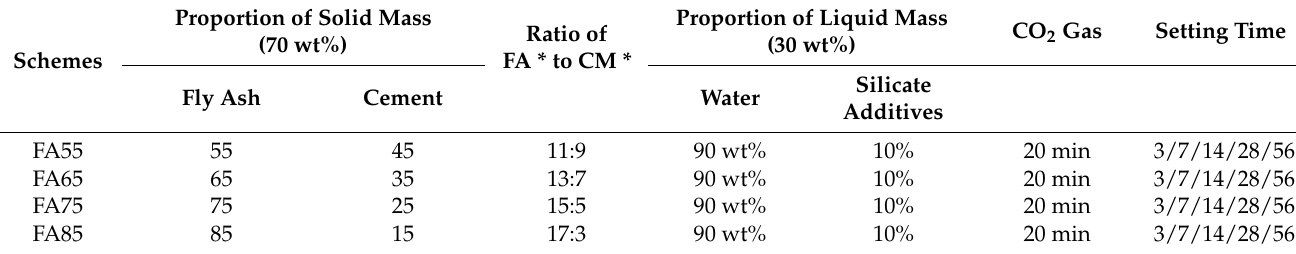
Table 1. The testing schemes of various material ratios and setting times of CMFB.